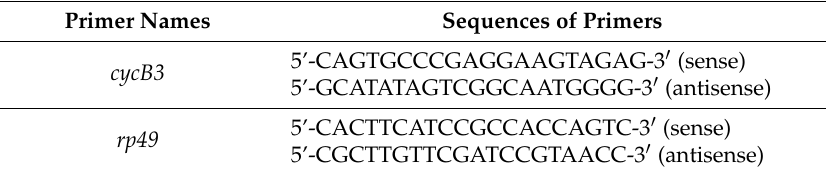
Table 3. The primers in conducting qPCR